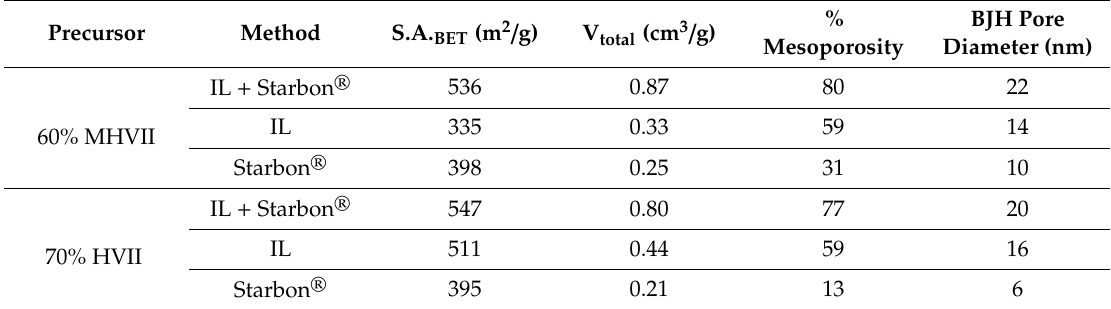
Table 9. Nanoporosity data of carbons obtained from Maize + Hylon VII (60 wt% amylose) and